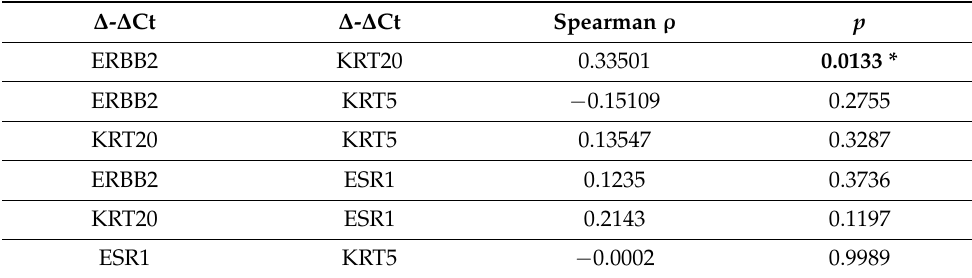
Table 5. Spearman correlation analyses of ∆ - ∆ CT = ∆ CT [RC] − ∆ CT [before NAC]) KRT5, KRT20, ERBB2 and ESR1; significant results are marked with *. ∆ - ∆ Ct ∆ - ∆ Ct Spearman ρ